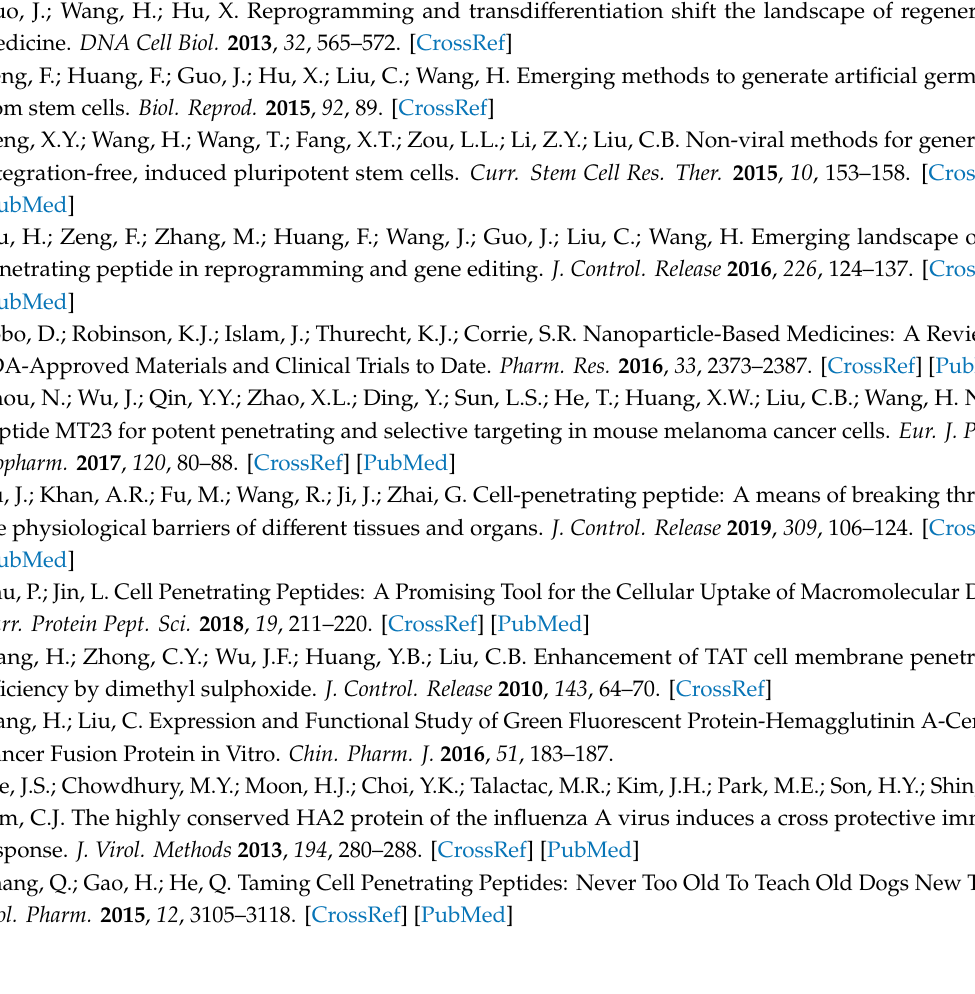
Figure S1: Statistical analysis. (A) Corresponds to Figure 2B. (B) Corresponds to Figure 2D w / o DMSO pretreatment. (C) Corresponds to Figure 2D of 5% DMSO pretreatment. (D) Corresponds to Figure 3B. (E) Corresponds to Figure 3D. (F) Corresponds to Figure 7C. Figure S2: Penetration e ffi ciency of Dot1l in di ff erent conditions. (A) Quantification of Dot1l penetration with or without TB treatment. (B) E ff ects of di ff erent incubation times on the Dot1l penetration. (C) Penetration e ffi ciency of Dot1l in di ff erent cell lines. (D) Comparison of penetration e ffi ciency from di ff erent CPPs in MCF7 and HSC-T6 cells. Figure S3: Prediction of di ff erent CPP-membrane interactions in aqueous and lipid bilayer environments. Figure S4: Dot1l safety examined by LDH release, cell cycle, and cell apoptosis assay. (A) LDH release quantity assay in MCF7 cells treated with Dot1l at di ff erent concentrations. (B) Cell cycle examined by flow cytometry. (C) Cell apoptosis examined by flow cytometry with or without Dot1l incubation. Figure S5: Stability of Dot1l / pDNA complex and Dot1l peptide-mediated pDNA transfection. (A) Agarose gel examination of Dot1l peptide and pcDNA3.1-GFP complex at di ff erent N / P ratios in 50% serum solution. (B) Transfection e ffi ciency quantification of Dot1l peptide / pDNA in di ff erent cell lines. (C) Dot1l peptide-mediated pDNA transfection in MCF7 cells (48 h) examined by fluorescence microscope. (D) Dot1l peptide-mediated pDNA transfection in HSC-T6 cells (48 h) examined by fluorescence